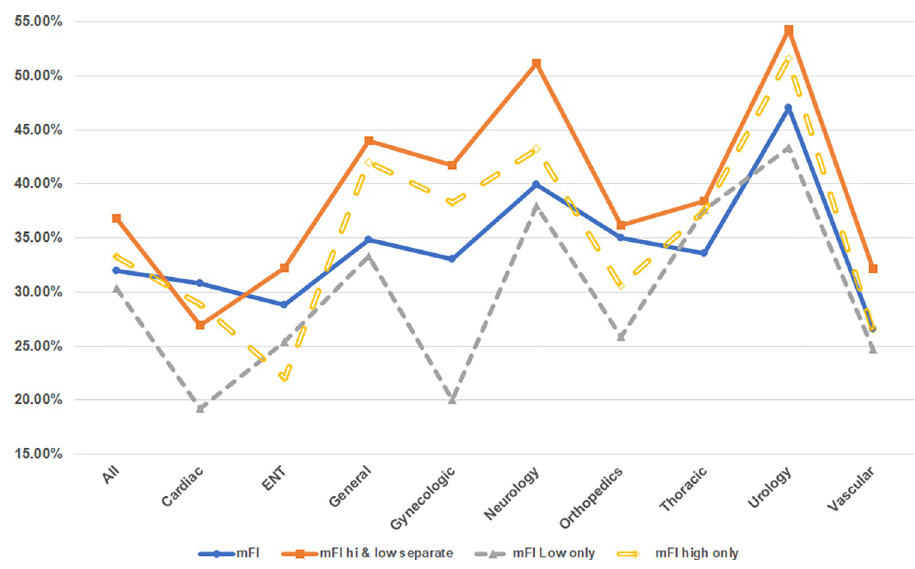
Fig 1. Leave-one-out comparison of ANN prediction accuracy against original models.